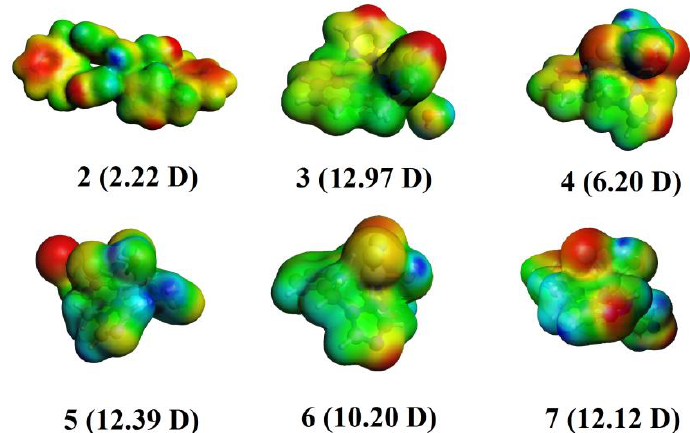
Figure 4. Molecular electrostatic potential maps of the studied complexes denoting their permanent dipole moments in Debye (D). Blue regions indicate charge depletion, and red regions indicate charge accumulation.